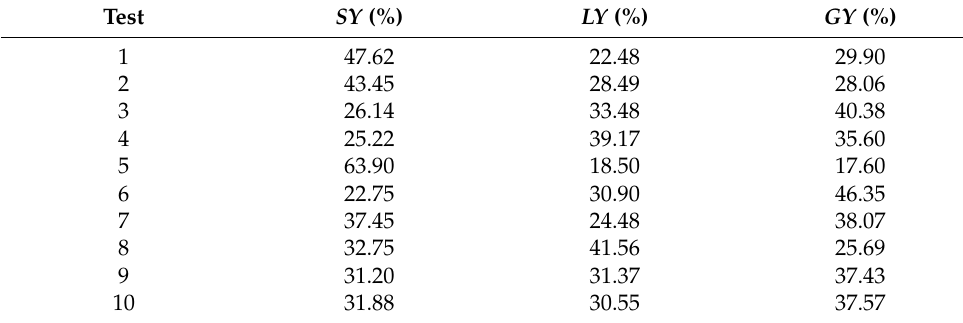
Table 4. Experimental data for product yields from Spirulina platensis solar pyrolysis. Test SY (%) LY (%) GY